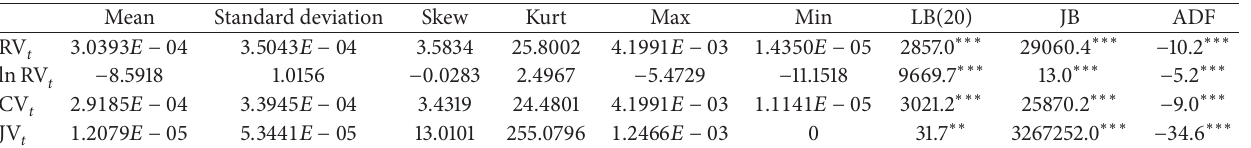
Table 2: Descriptive statistics.